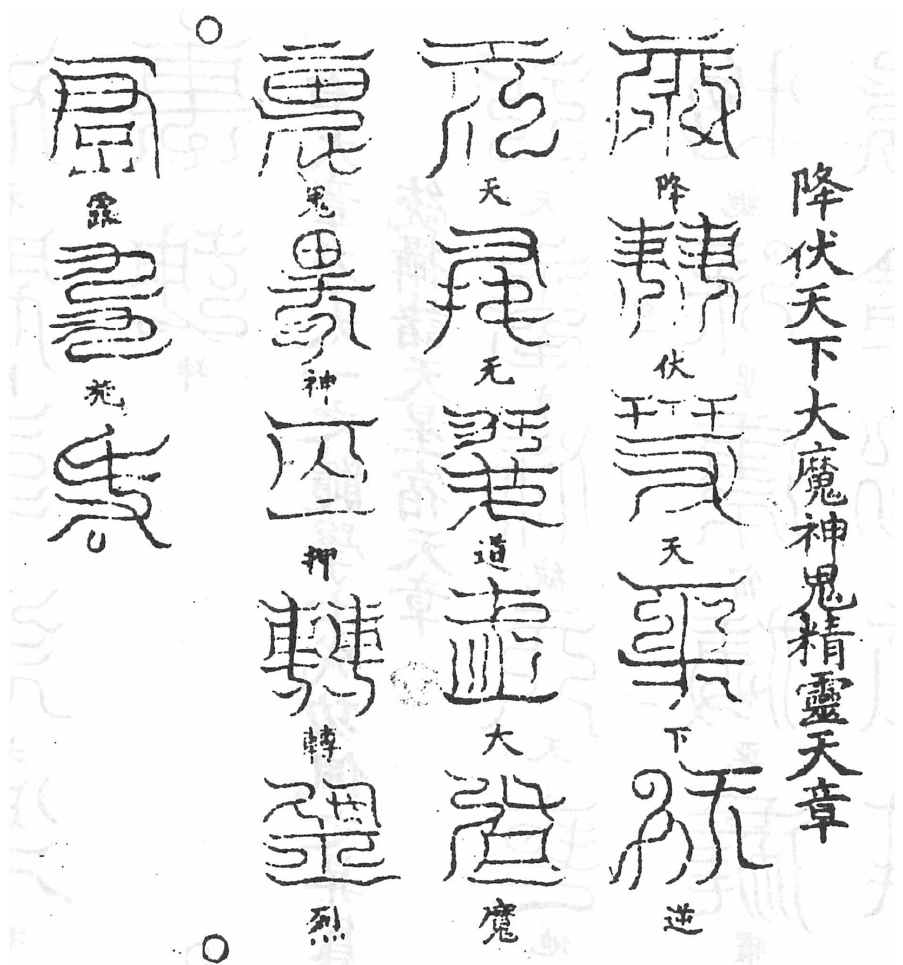
Figure 5. Celestial Script for subduing “great demons.” From DZ 1220: 140. 3ab.